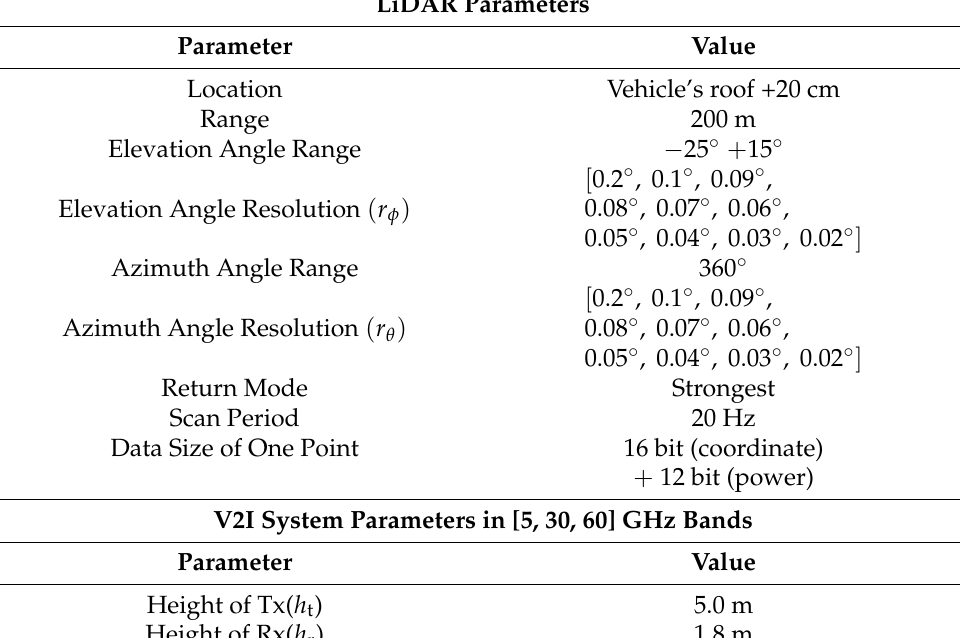
Table 1. Simulation